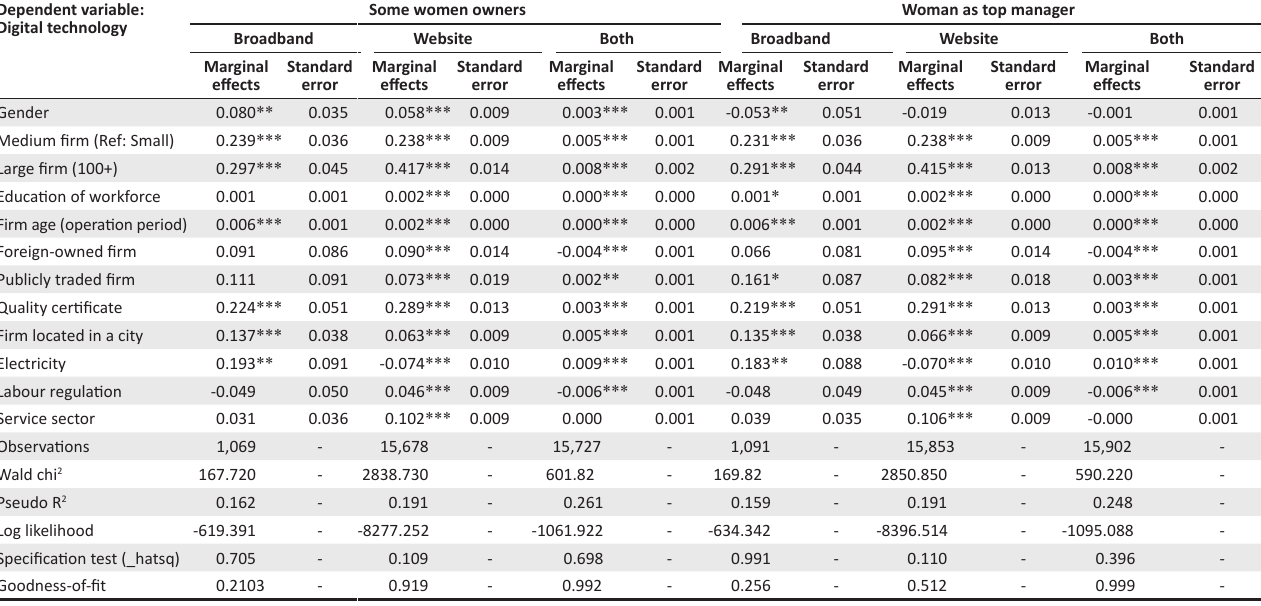
TABLE 2: Correlates of firms’ adoption of digital technologies for business activities. Dependent variable: Digital